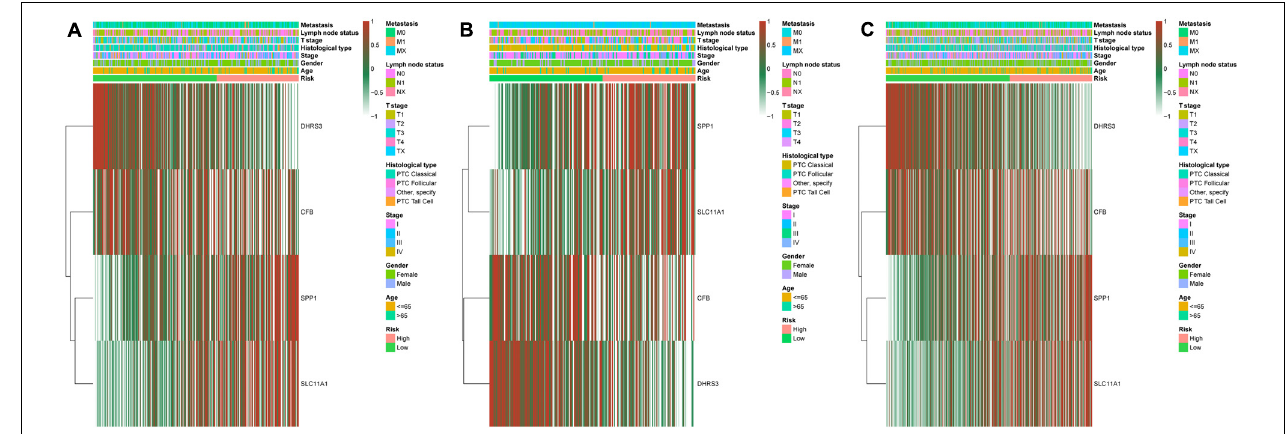
FIGURE 7 | Distribution of four-gene expression profiles and clinical features of each cohort. Validation cohort A (A) . Validation cohort B (B) . Entire cohort (C) .